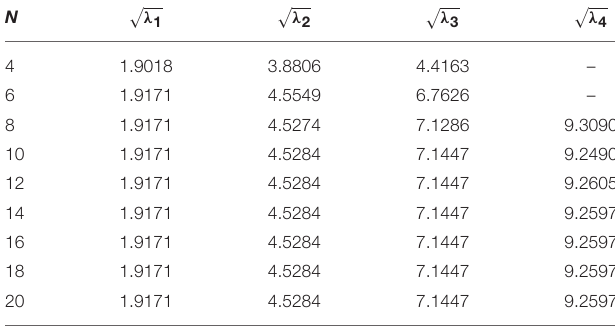
TABLE 10 | Convergence for CF case.